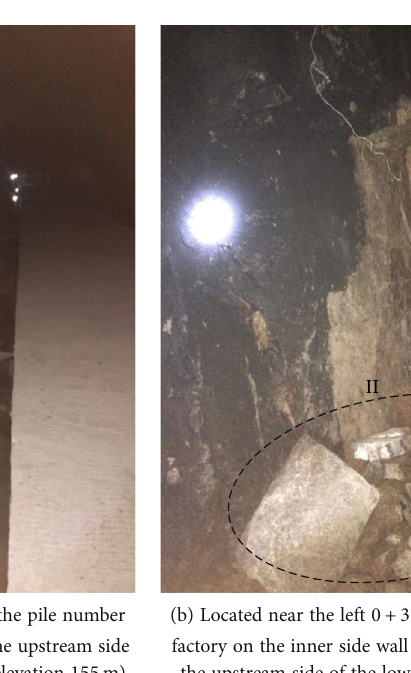
Figure 11: Collapses of rock mass in microseismic accumulation